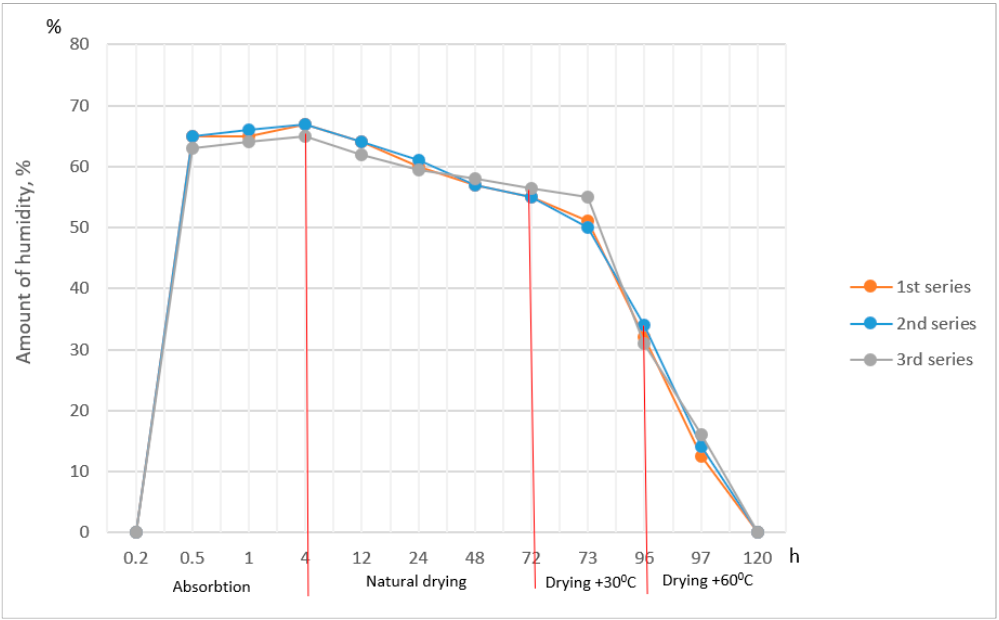
Figure 4. Drying process depending on the moisture content.